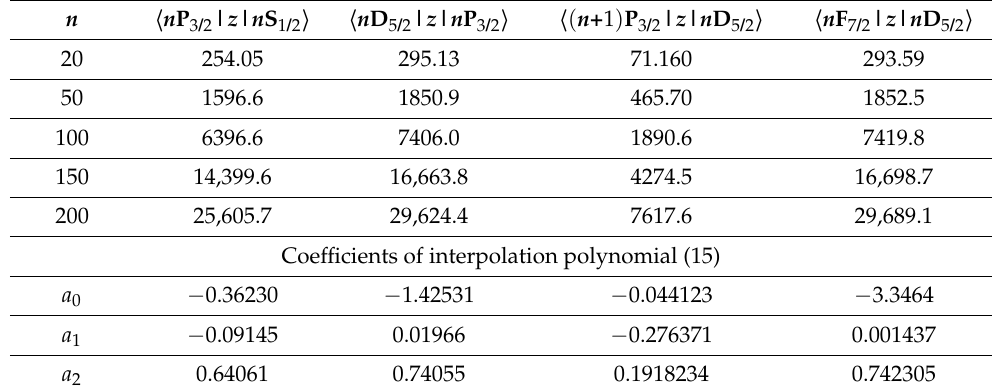
Table 7. Numerical values (in atomic units) and coefficients of the quadratic polynomial presentation (15) for the matrix elements of electrodipole transitions from Rydberg n S 1/2 and n D 5/2 states of Li atoms. The bra-vector states are the states of higher energy, and the ket-vector states are the lower-energy states. The corresponding transition frequencies are presented in Table 2.